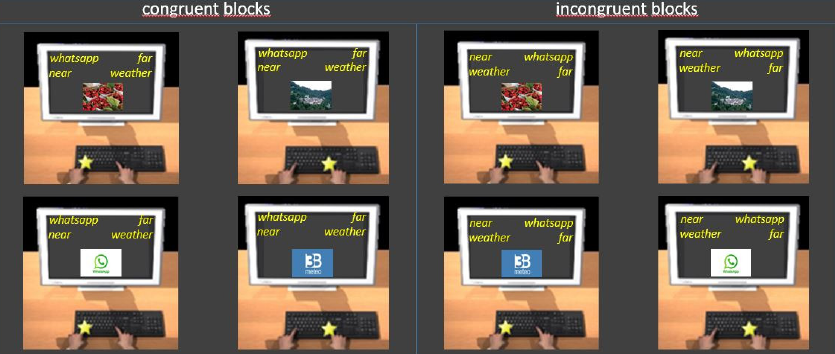
Figure 4. Examples of trials in congruent ( left panel ) and incongruent ( right panel ) blocks of Experiment 3. Participants were asked to press the E key with their left hand when the category to which the image belongs was written at the top left and to press the I key with their right hand when it was written at the top right (see the text for details).